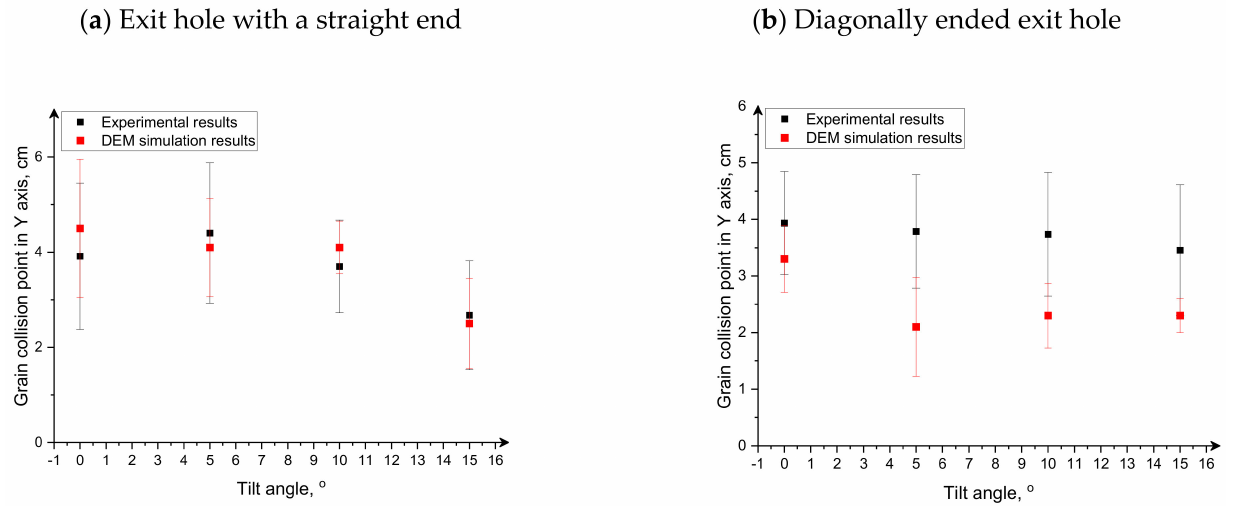
Figure 10. Grain collision point measured in Y axis for different tilt angles—experimental and simulation